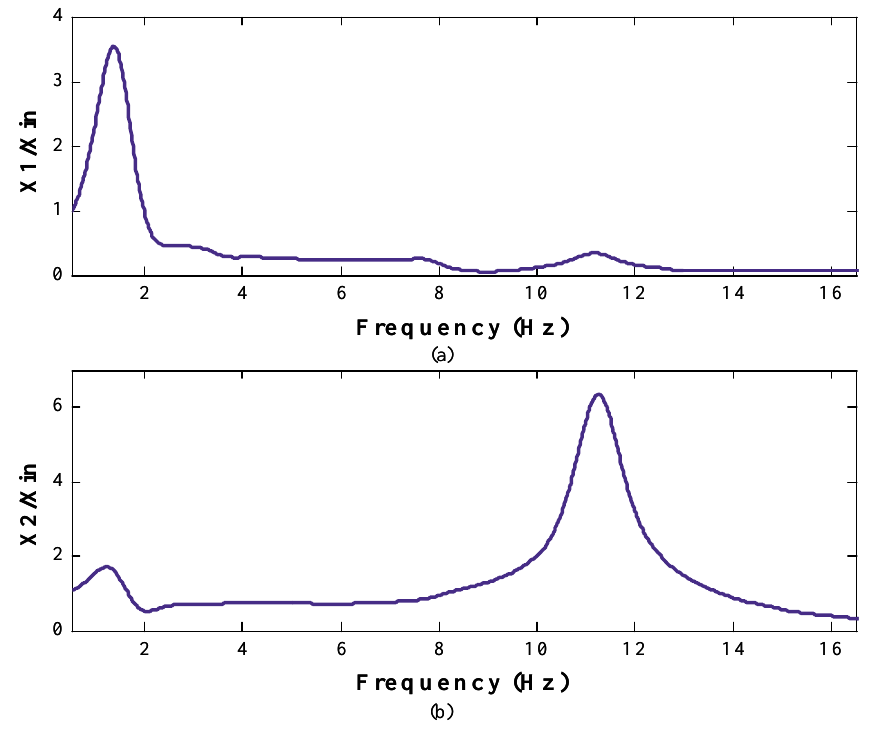
Fig. 3. Undamped Dynamics of the Quarter-Car Rig at 10 psi: (a) Sprung Mass Transmissibility; (b) Unsprung Mass